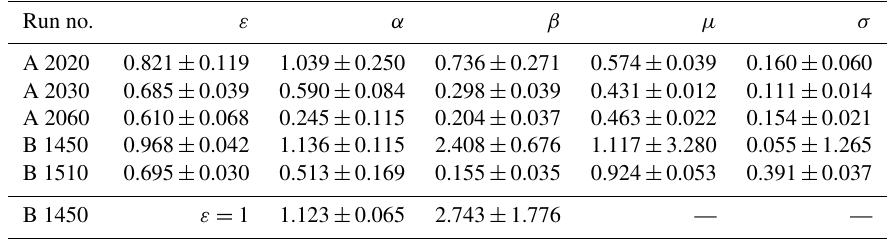
Table 3. Results of least-squares fit of Eq. (1) to observed FSD data. Run no. ε α β µ